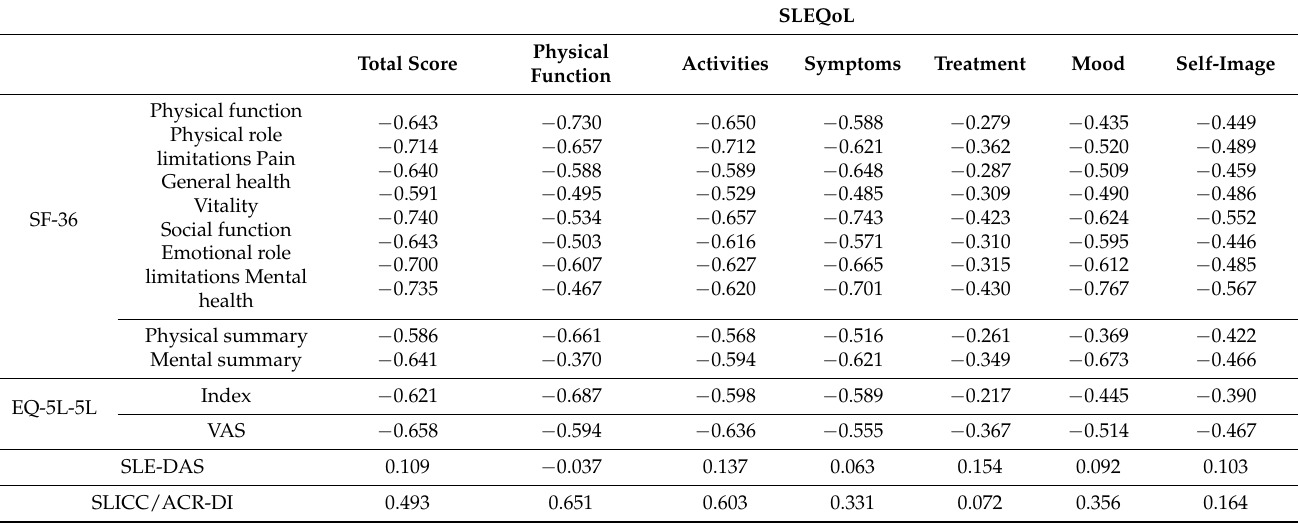
Table 5. Correlations between SLEQoL and SF-36, EQ-5D-5L, SLE-DAS, and